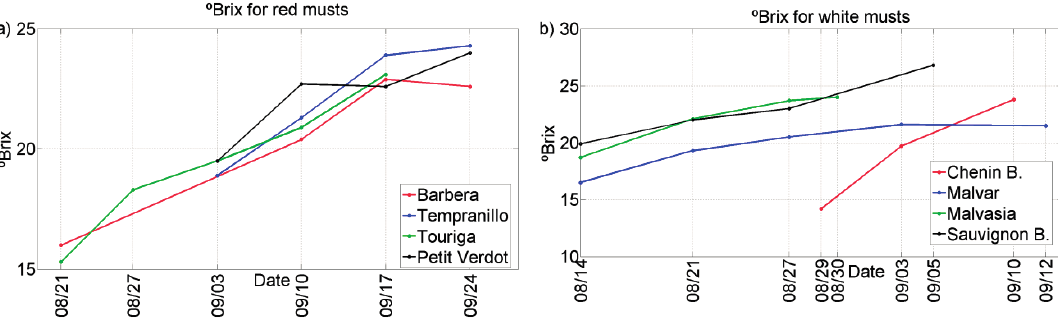
Figure 5. Evolution of °Brix for musts of 2012 harvest. ( a ) Red musts; ( b ) White